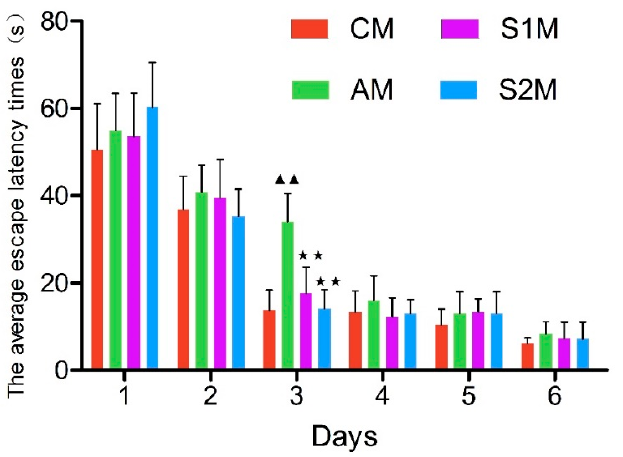
Figure 2. Time-dependent effects of the navigation training on the average escape latency in rats. As the training time increased, the average escape latency gradually decreased in all groups towards a stable spatial memory at Day 6. Data are presented as Mean ± Standard Deviation (SD; n = 10/group). The in-graph symbols indicate: ▲▲ p < 0.01 versus group CM ; ** p < 0.01 versus group AM .